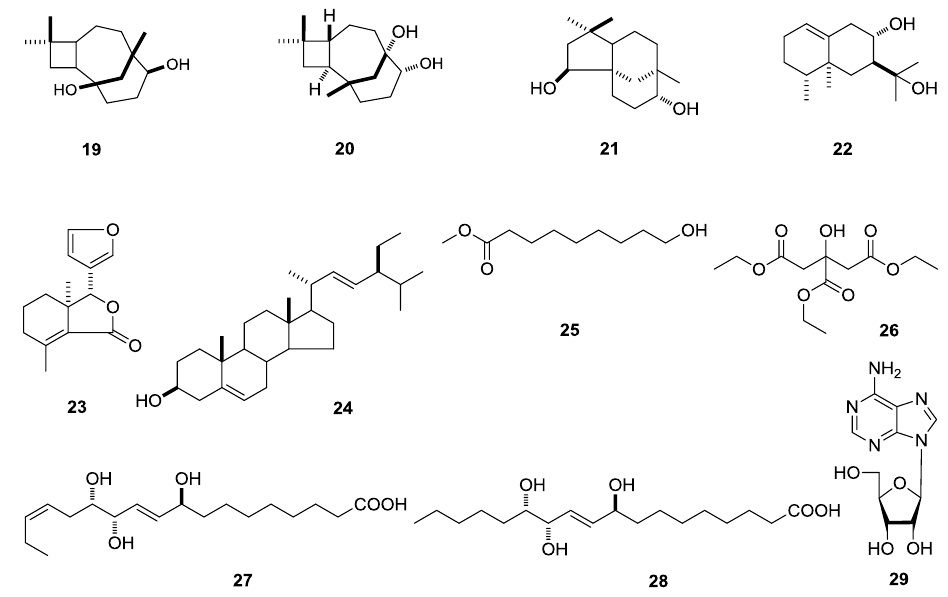
Figure 2. The known compounds 5 – 29 obtained from the aerial parts of P. indica .